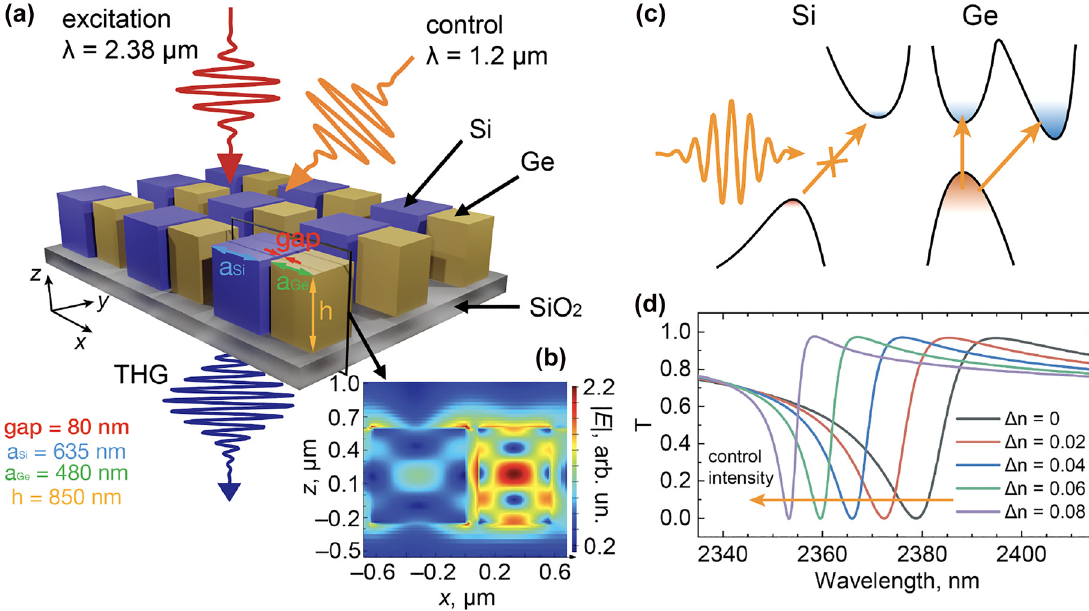
Figure 1: Q-boosting metasurface design. (a) A schematic image of a Q-boosting metasurface. The unit cell consists of germanium and silicon pillars of square cross-section with a = 635 nm for silicon and a = 480 nm for germanium. The height of the structure is h = 850 nm. The gap between the pillars is side of a Si Ge 80 nm. (b) The electric field of a quasiguided mode inside a unit cell of the metasurface at a resonant wavelength of 2380 nm. (c) Schematically, the control pulse produces photogenerated free carriers in the Ge nanoparticles while the Si nanoparticles